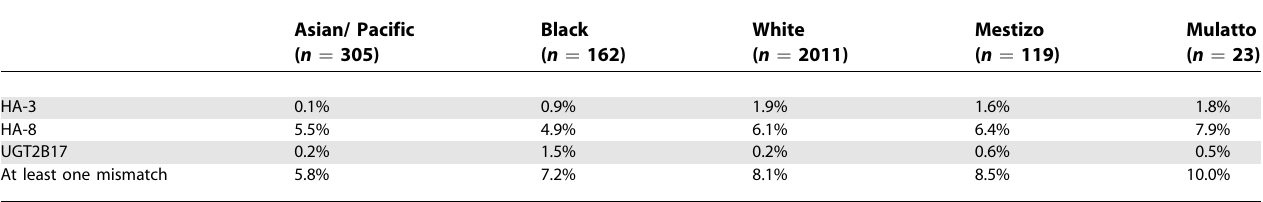
Table 7. Estimated Disparity Rates for Broadly Expressed Minor H Antigens in HLA-Matched Transplant Sib Pairs Corrected for the Frequencies of the HLA Restriction Molecule